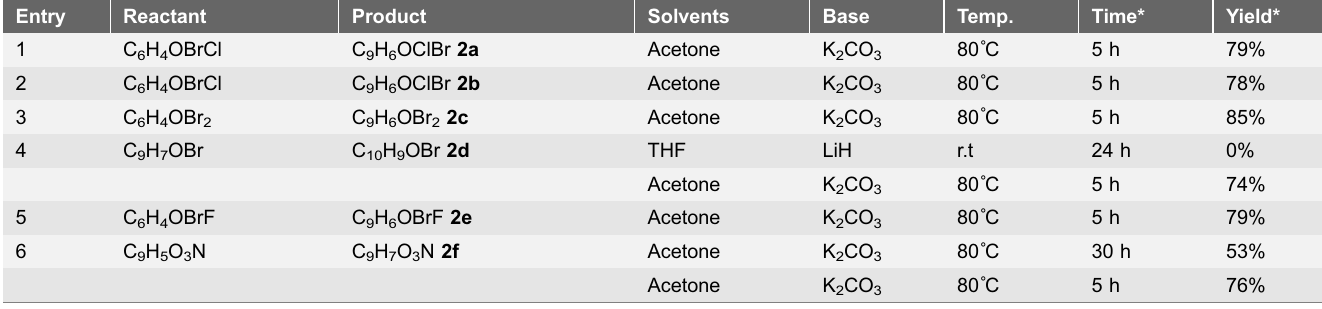
Table 1. Optimization of reaction conditions for compounds 2a–2f